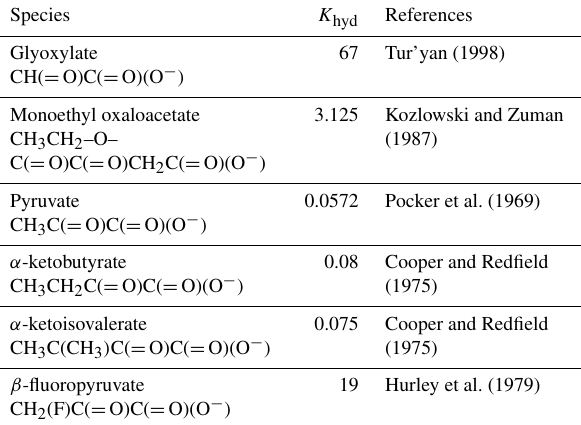
Table 1. Experimental hydration constants for carboxylate